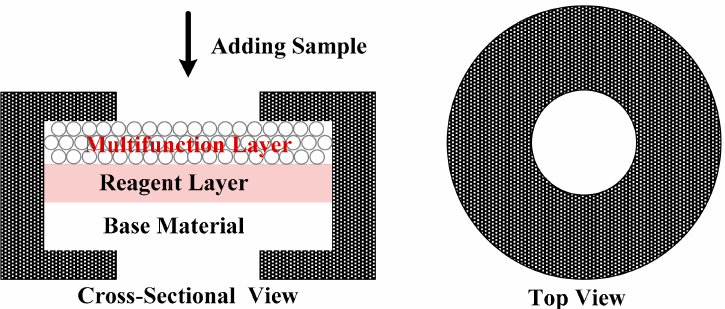
Figure 9. Structure of dry chemical diagnostic reagent in